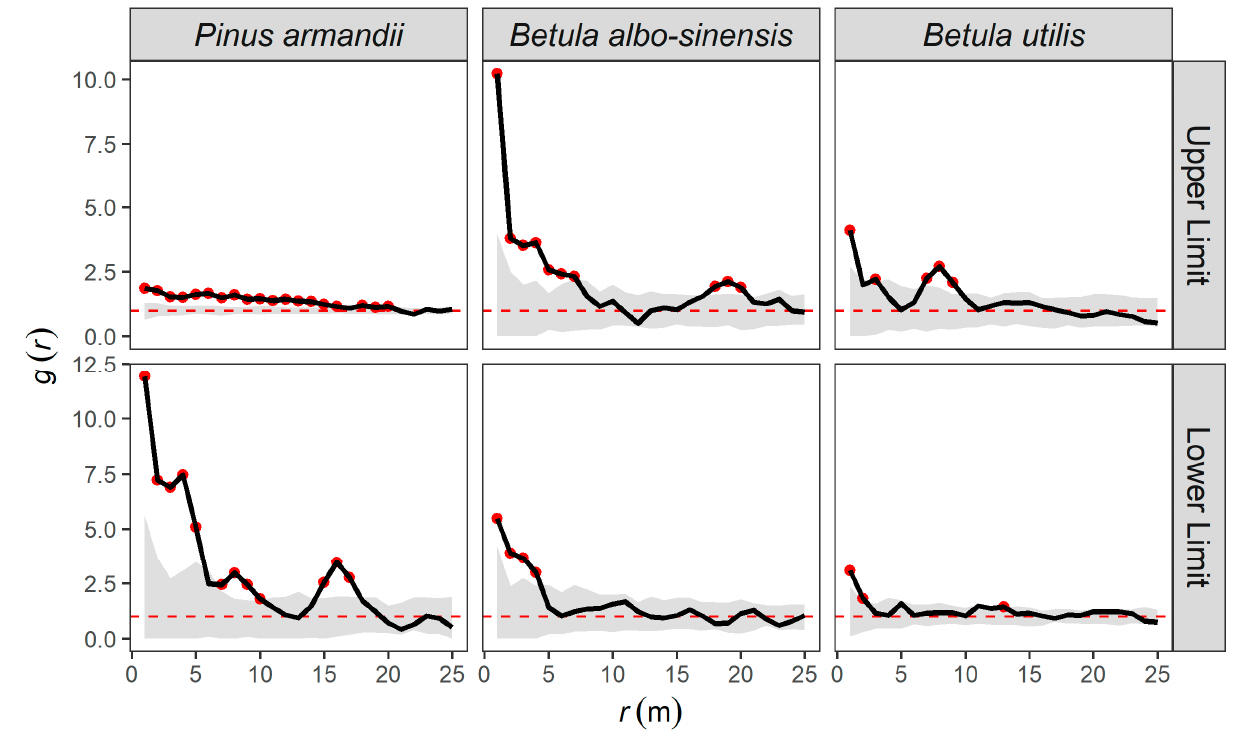
Figure 5. The CSR null model analysis of the spatial patterns of the three species at the upper and lower limits of the treeline patch. Note: The black lines are the observed lines, namely the actual lines of the species patterns at 0–25 m; the red dashed lines are the expected lines; the red points are the g -values beyond the upper envelope at a corresponding scale.